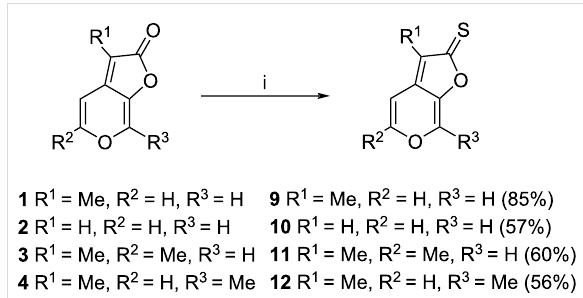
groups ( 9 – 12 ), has been prepared from appropriate karrikins. Starting materials, karrikins KAR 1 ( 1 ), KAR 3 ( 3 ) and KAR 4 ( 4 ) (Figure 1) were synthesized from pyromeconic acid ( 5